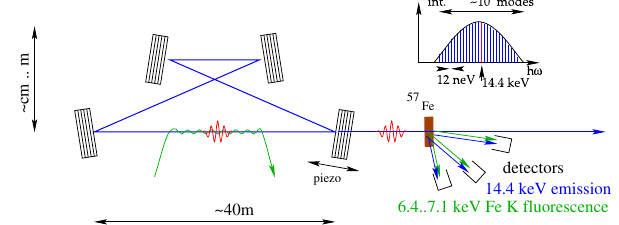
FIG. 2. Schematic of the cavity-stabilization scheme. A nuclear- resonant sample (here 57 Fe) is placed into the XFELO output, and the nuclear-resonant and K -shell electronic fluorescence are monitored as a function of cavity tuning with a piezoelectric actuator. A feedback loop keeps one of the ca. 10 6 longitudinal modes of the XFELO on resonance with the sample.